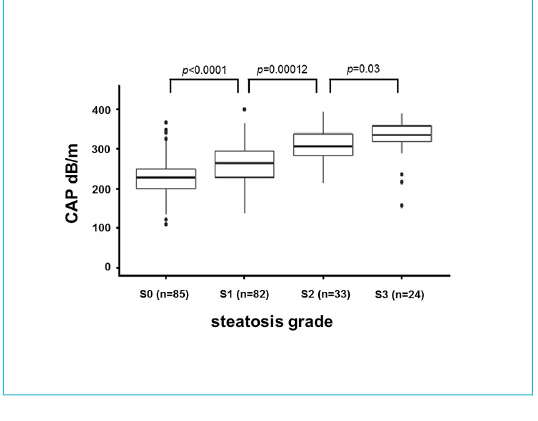
Figure 2: Controlled attenuation parameter (CAP) values accord- ing to the degree of steatosis S0 to S3.